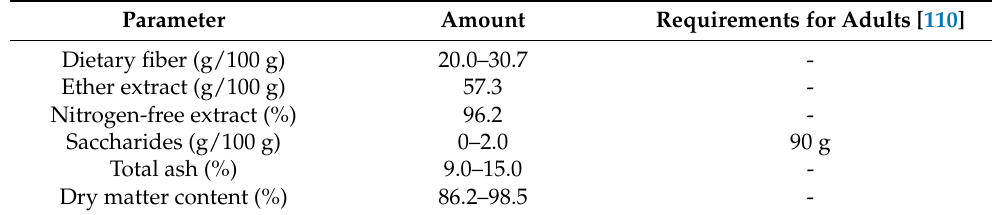
Table 2. Nutritional analysis of Yarrowia lipolytica protein powder (dry weight).